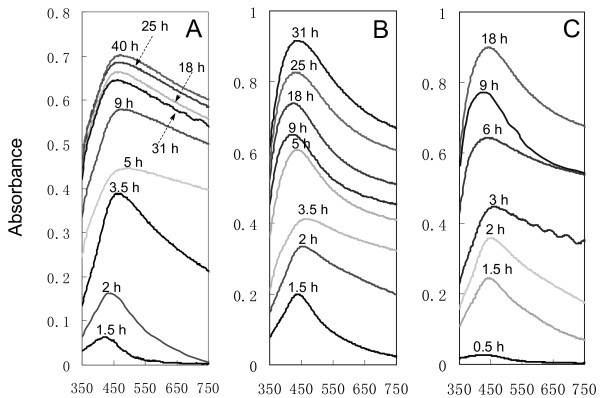
UV-Vis absorption spectra of the AgNPs films prepared in AgNO3/BuNH2 ethanolic solutions at different reaction time. The reactants concentrations: (A) 1/0.5 mM, (B) 5/2.5 mM, and (C) 10/5 mM. The background spectra have been subtracted for all the UV-Vis absorption spectra.